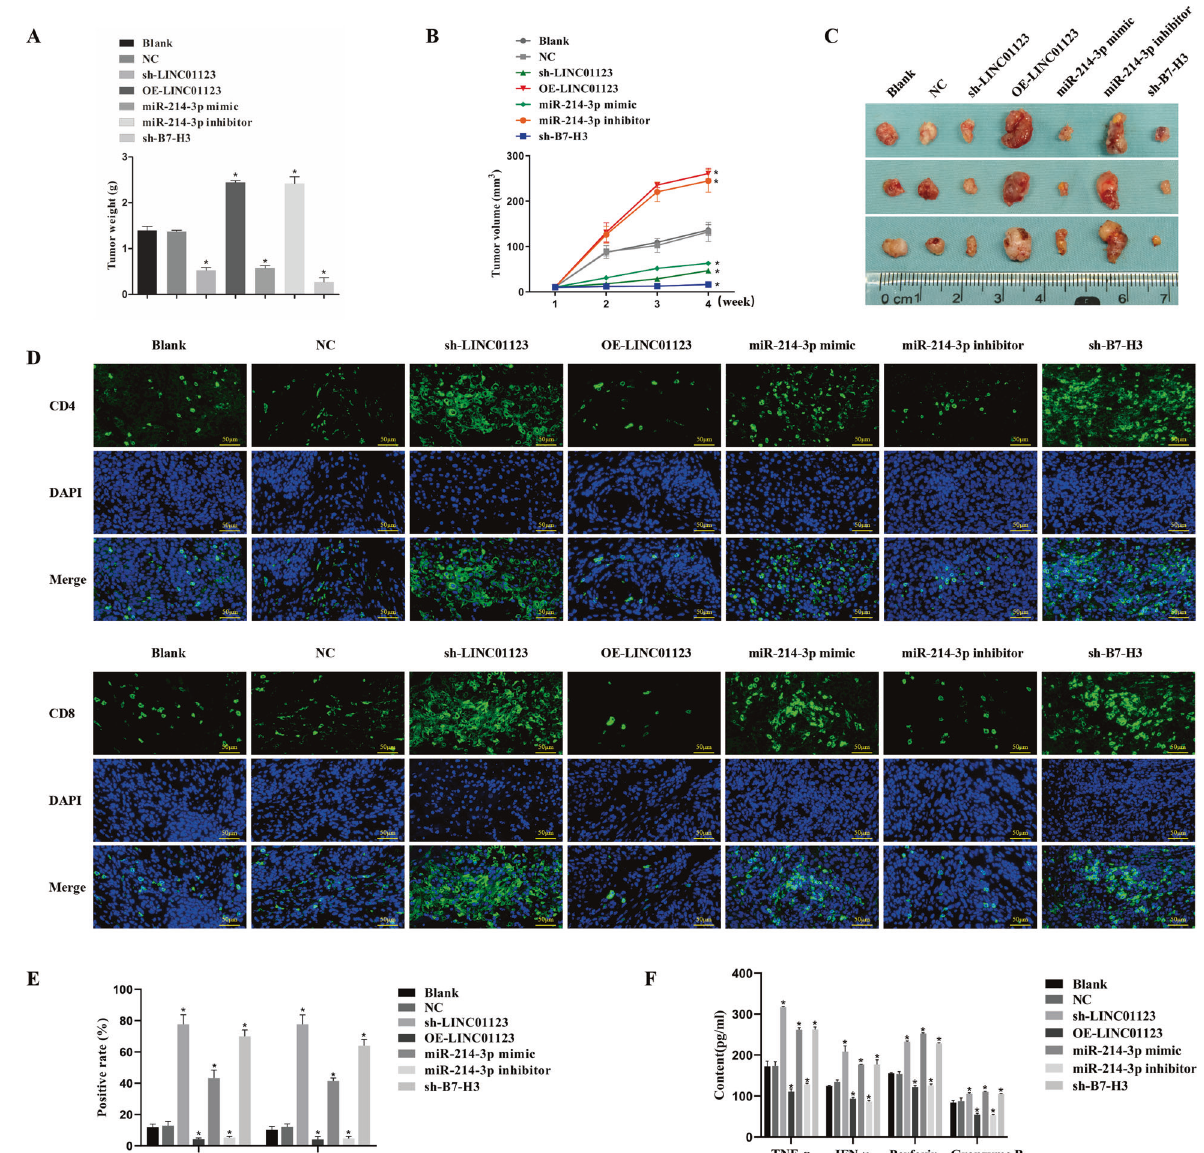
Fig. 5 Downregulation of LINC01123 or B7 – H3 or upregulation of miR-214-3p inhibits the tumorigenicity and immune escape of HNSCC cells in vivo. SCC-7 cells were subcutaneously injected into C3H mice and treated with sh-LINC01123, OE-LINC01123, miR-214-3p mimic, miR- 214-3p inhibitor, or sh- B7 – H3 after tumor formation. A Tumor weights of mice from each group. B Tumor-volume growth curve of each group ( n = 3). C Tumor images at week 4. D Immuno fl uorescence staining of CD4 and CD8 in tumor specimens (×400). E Statistical analysis of CD4 and CD8 immuno fl uorescence results. F Expression of TNF- α , IFN- γ , perforin, and granzyme B in peripheral blood of tumor-bearing C3H mice, as detected by ELISA. * P < 0.05 versus the blank group. The experiment was repeated three